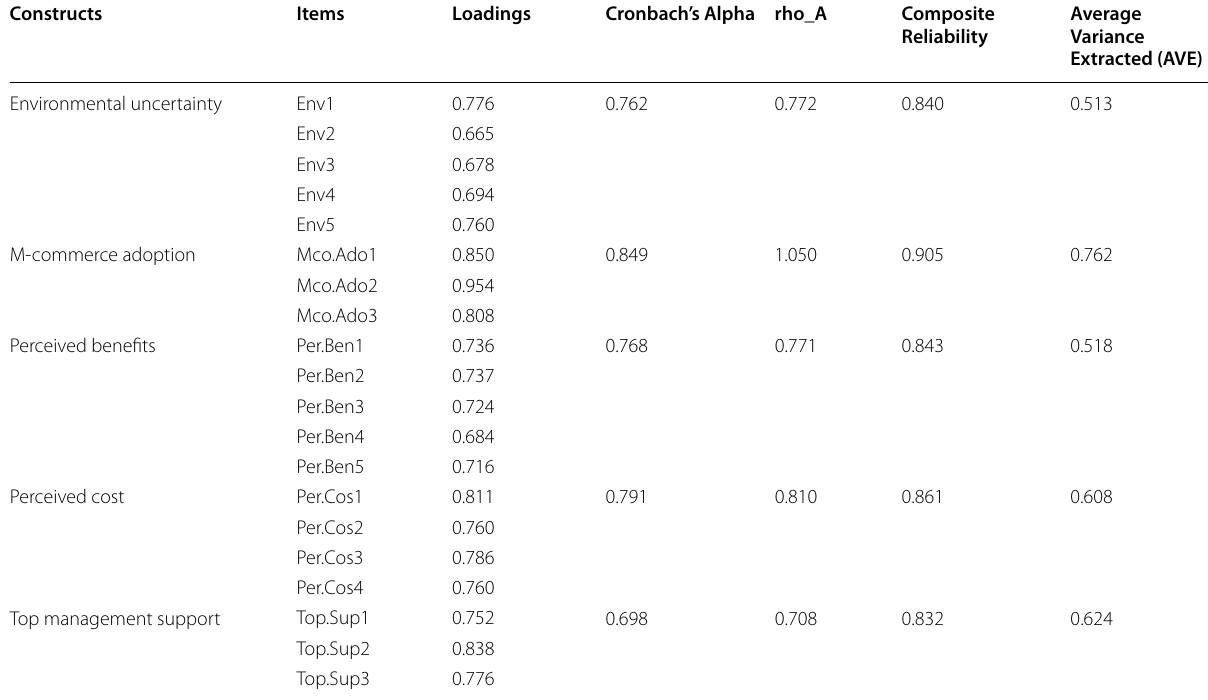
Table 3 Loadings, Cronbach’s alpha, rho_A, composite reliability, average variance extracted (AVE)